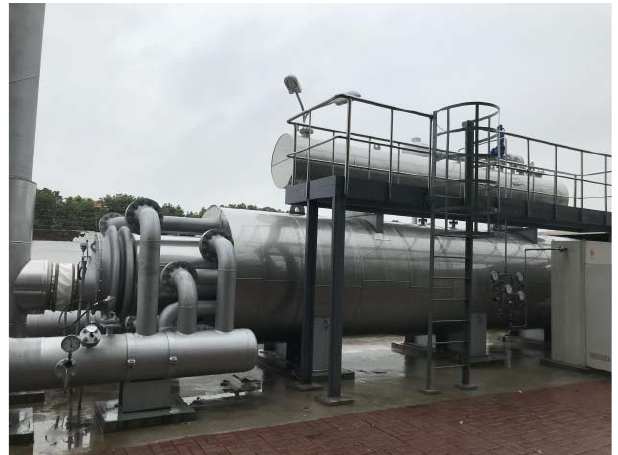
Figure 25. Main body diagram of the heating furnace.